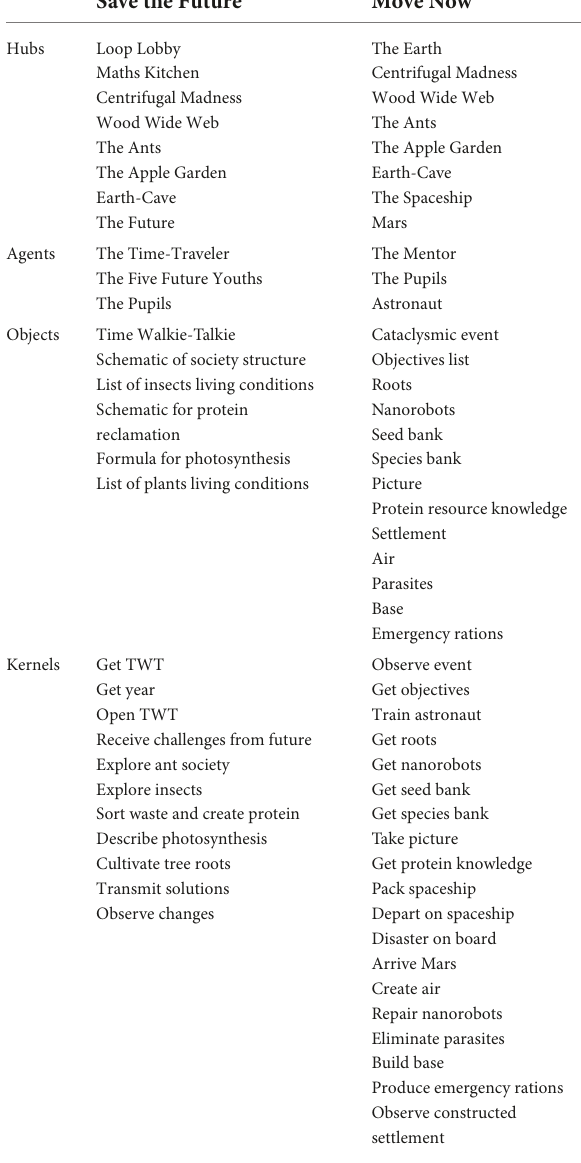
TABLE 6 Hubs, objects, agents, and events of Save the Future and Move